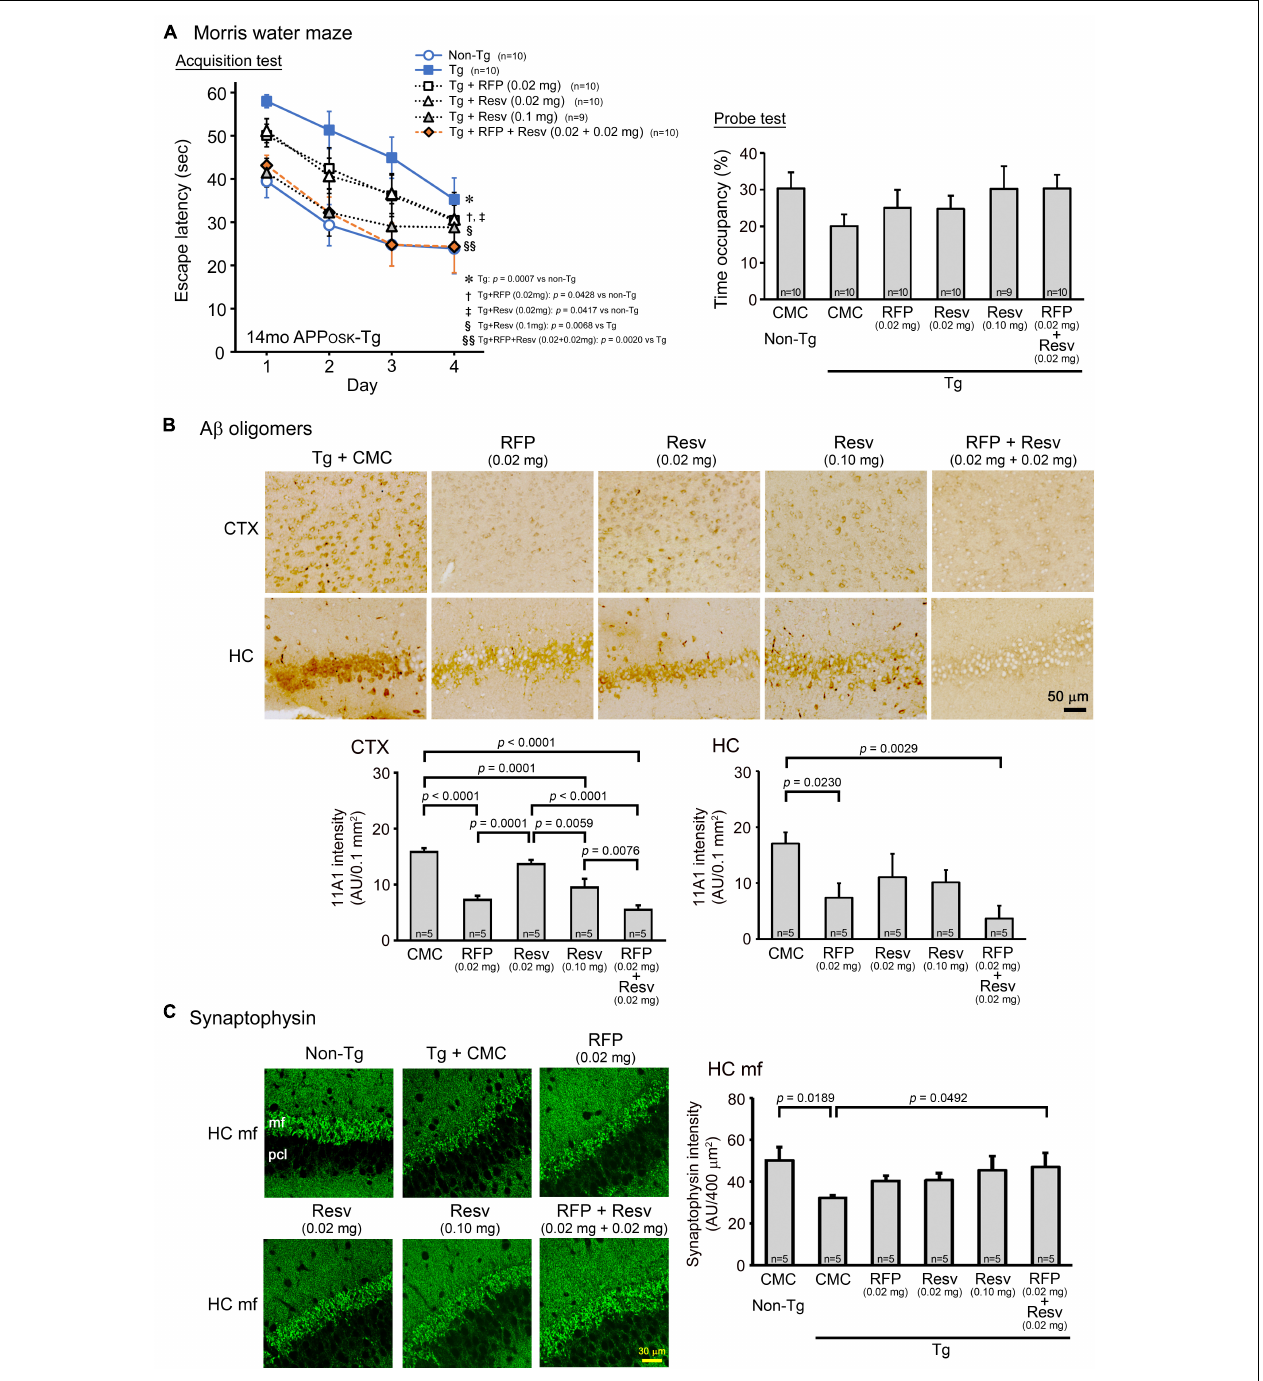
FIGURE 1 | Effects of intranasal rifampicin and resveratrol combination on memory and A β oligomer-related pathologies in APP OSK mice. Drug solution containing 0.02 mg rifampicin (RFP) alone, 0.02 or 0.1 mg resveratrol (Resv) alone, 0.04 mg combinatorial medicine (0.02 mg each drug), or carboxymethylcellulose (CMC) as a control was intranasally administered every day into 13-month-old mice for 1 month. (A) In the Morris water maze acquisition test, the combinatorial medicine and high-dose resveratrol showed a significant improvement of mouse memory to a level similar of non-Tg littermates. (B,C) After the water maze task, brain sections were stained with antibodies for A β oligomers (11A1) and synaptophysin. (B) The levels of A β oligomers in the cerebral cortex (CTX) and hippocampus (HC) were significantly attenuated by rifampicin alone and the combinatorial medicine. (C) The levels of synaptophysin in the hippocampal mossy fibers (HC mf) were significantly recovered by the combinatorial medicine to a level similar of non-Tg littermates. pcl, pyramidal cell layer. AU, arbitrary unit. Values represent the mean ± SEM.